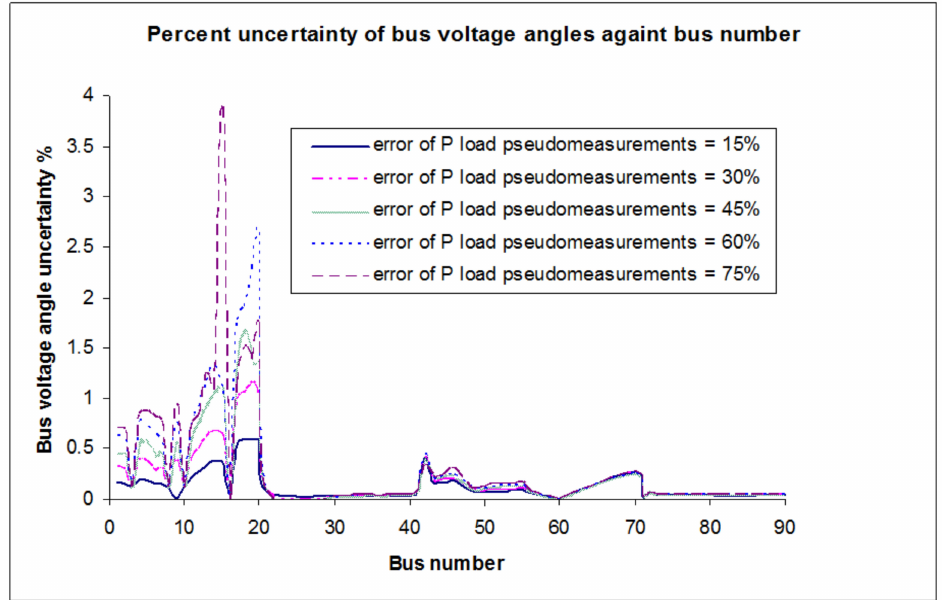
Figure 7. Bus voltage angle uncertainties with regard to errors in active load